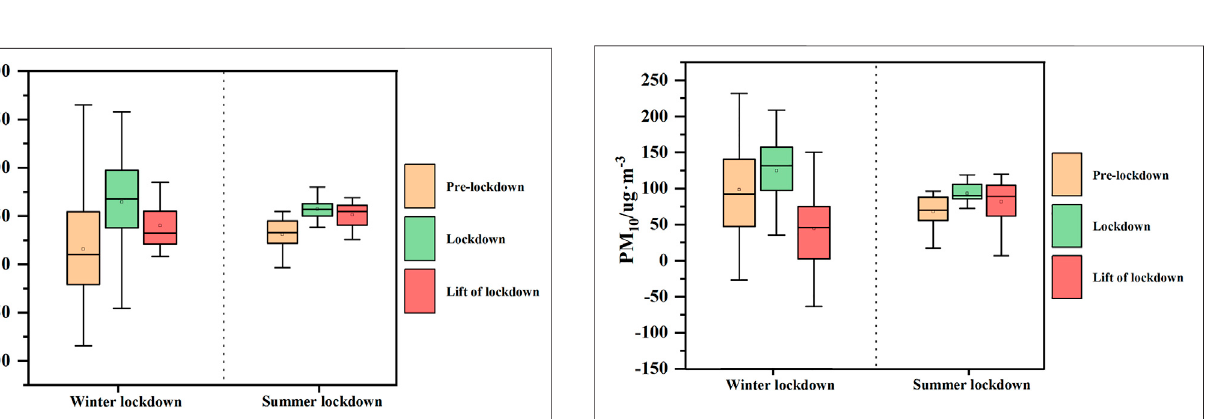
(39.54% decrease) compared to the corresponding historical period and 0.59 mg m − 3 (27.0%) compared to the period before the lockdown. During the summer lockdown, the CO concentrations decreased by 0.17 mg m − 3 (22.6%) compared with the corresponding historical period and by 0.01 mg m − 3 (2.4%)